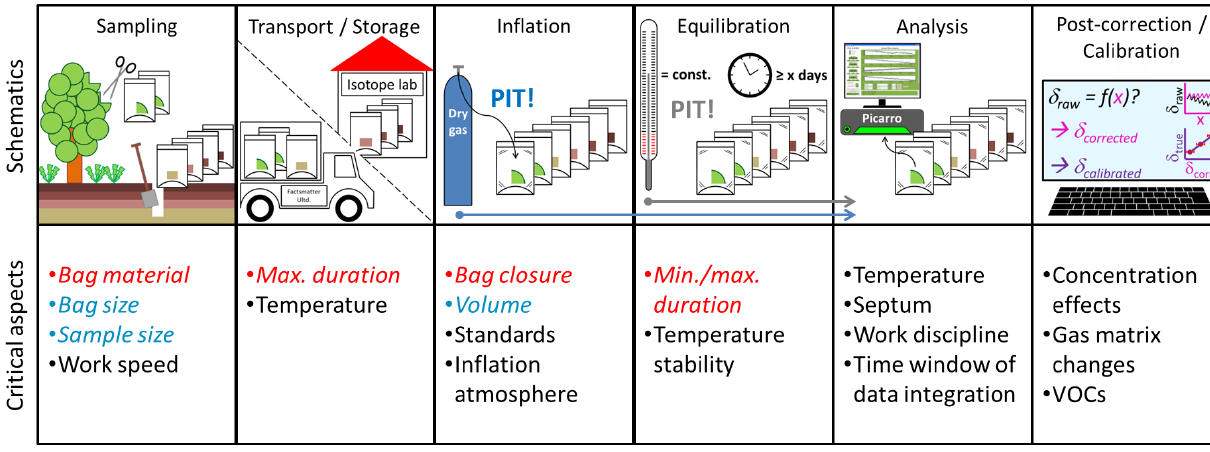
Figure 1. Schematics and critical aspects of the DVE-LS methodic steps. Aspects quantitatively investigated in this study are highlighted in red (empirical) and blue